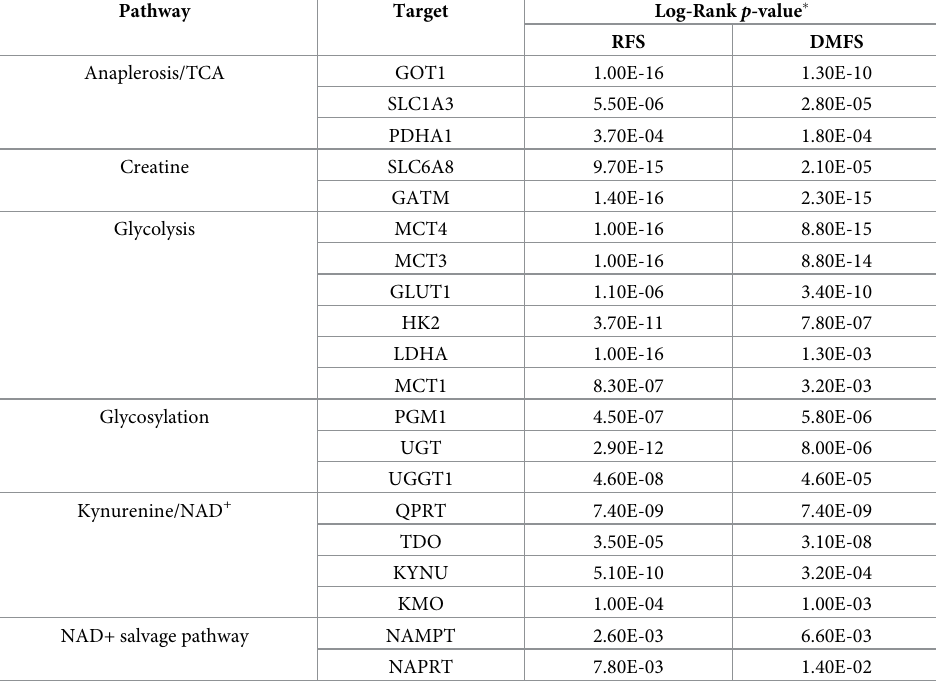
Table 1. Metabolic hits with prognostic capacity. Hits displayed with respective relapse-free survival (RFS) and dis- tant metastasis-free survival (DMFS) P-values. Pathway